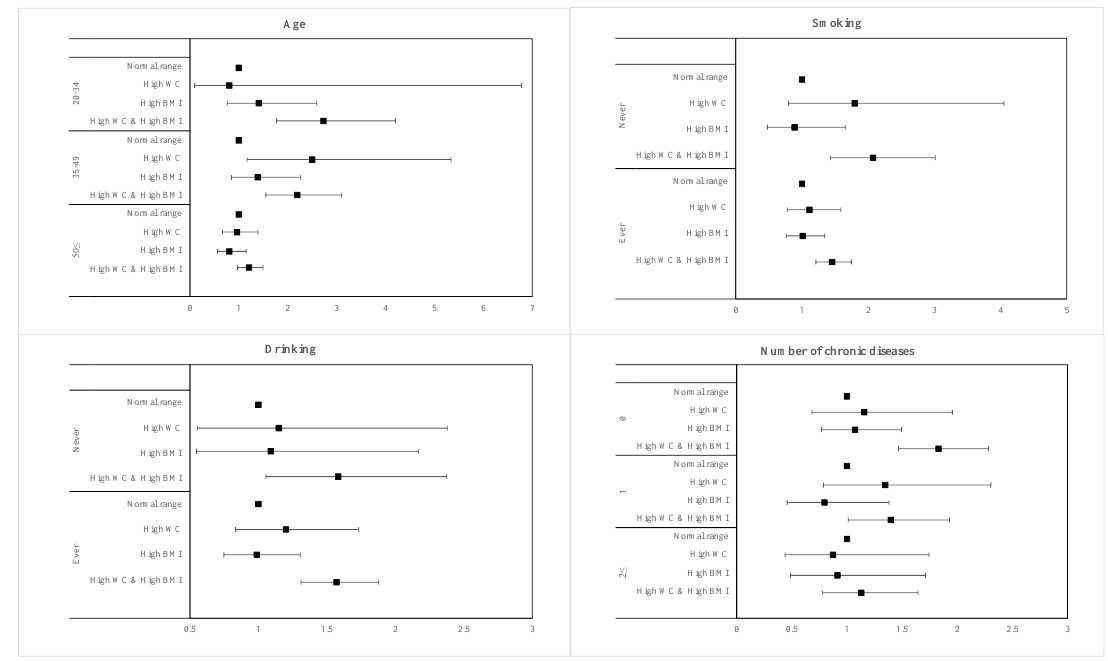
Figure 1. Forest plots of subgroup analysis results in